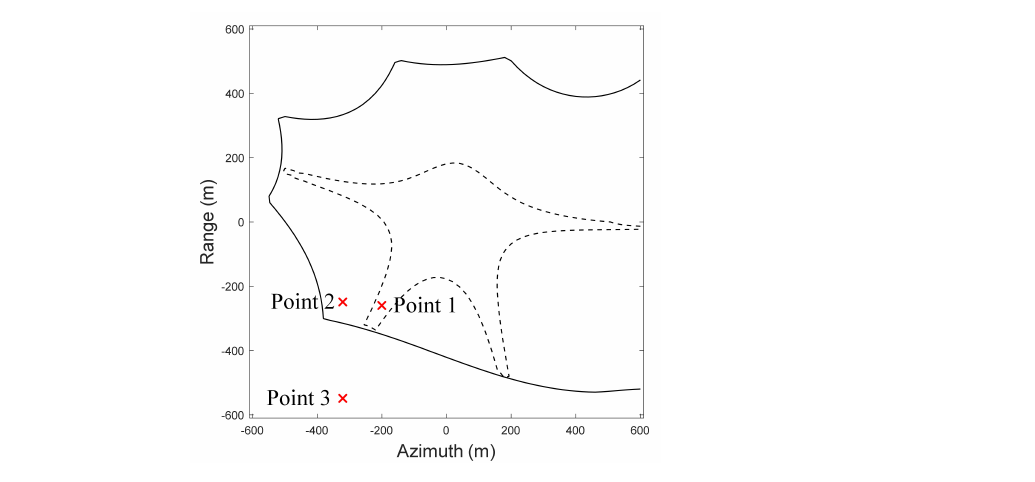
Figure 10. The swath limits for the two signal model and the distribution of simulated scatterers. The solid and dotted contour line represent the swath limits of the proposed model and the model in [16], respectively.